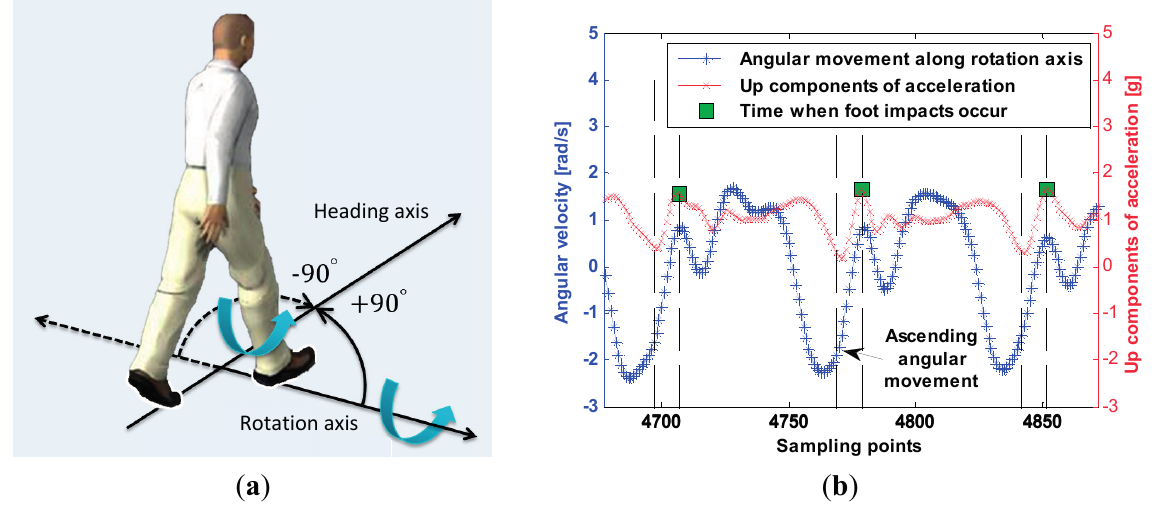
Figure 14. Illustration of 180° ambiguity elimination: ( a ) Description of rotation before a foot impacts with the ground; ( b ) Motion features mined from up acceleration components and angular movements are utilized to eliminate ambiguity.